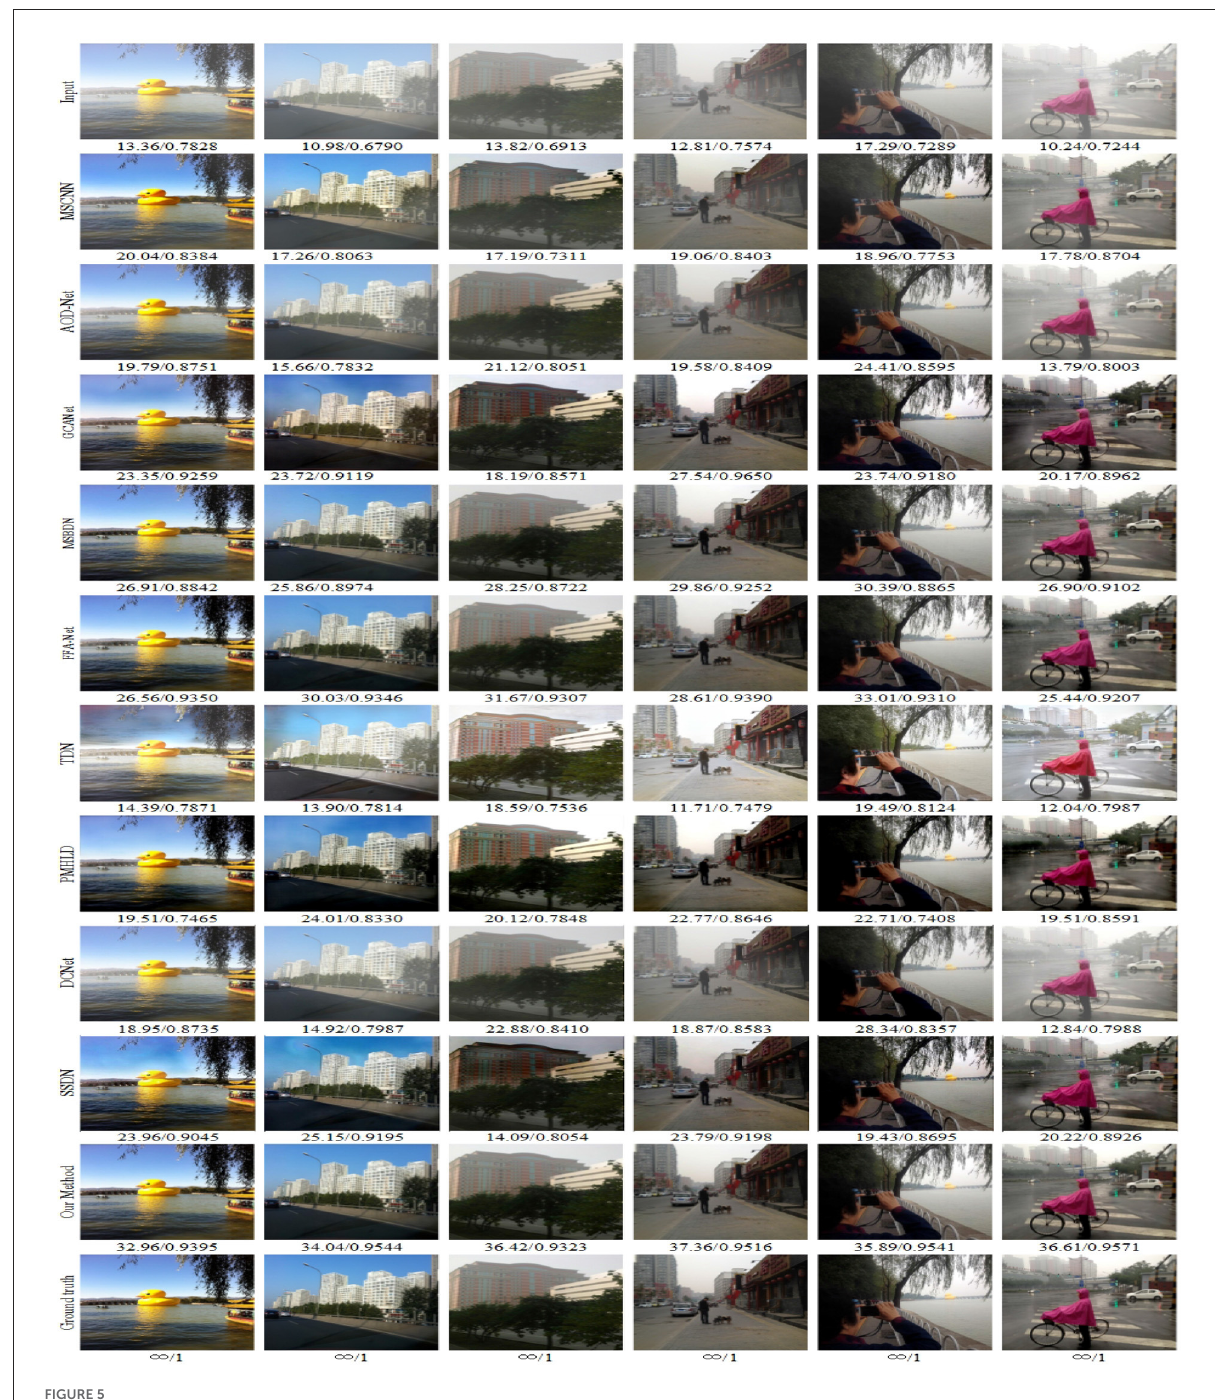
FIGURE5 Visual results on the SOTS dataset. Best viewed on a high-resolution